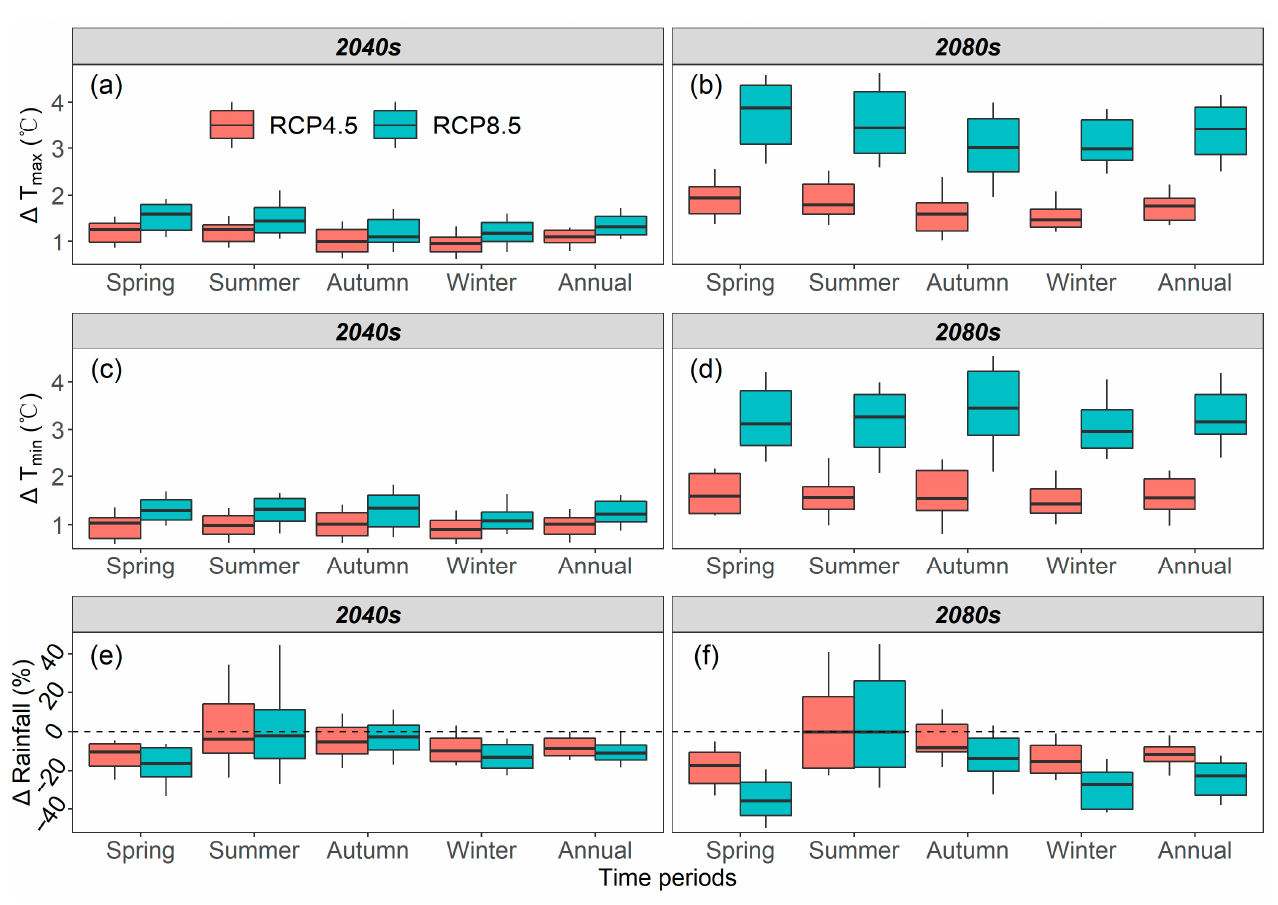
Figure 6. Projected seasonal and annual changes in temperature (°C) and rainfall (%) in 2040s and 2080s under both RCPs based on 34 GCMs compared to the baseline period. Data displayed are changes in the 40 − year averages for each of the 34 GCMs. The lower and upper whiskers show the 10th and 90th percentiles; box boundaries show the 25th and 75th percentiles; the black line within each box marks the median values.